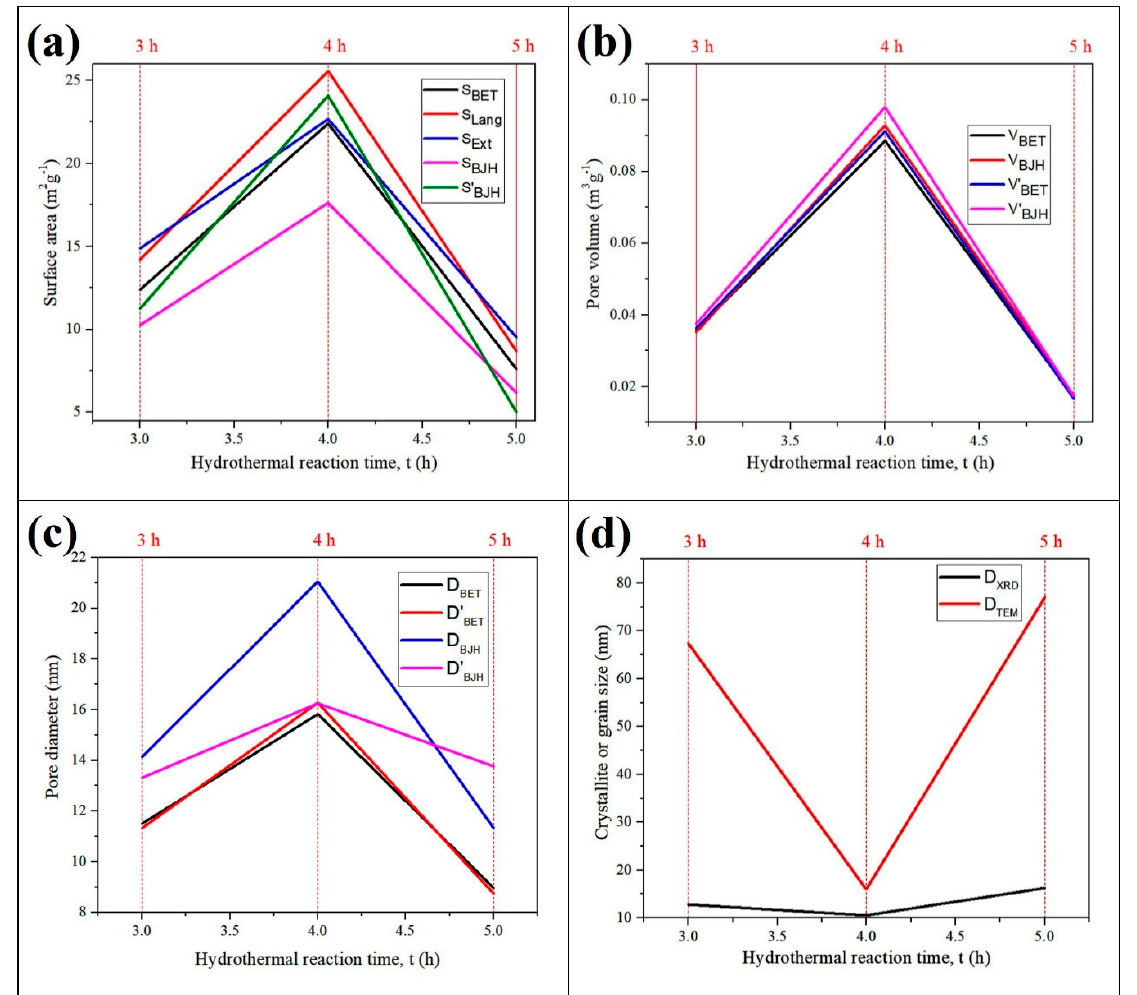
Figure 7. Effects of reaction time on the ( a ) surface area, ( b ) pore volume, ( c ) pore diameter and ( d ) crystallite or grain size of Fe 3 O 4 @C-T 190 t 3 , Fe 3 O 4 @C-T 190 t 4 and Fe 3 O 4 @C-T 190 t 5 nanocomposites obtained by hydrothermal synthesis.